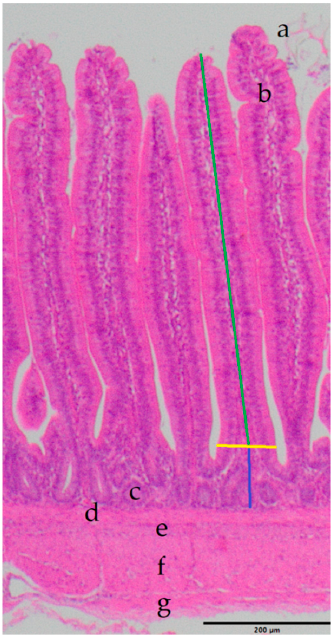
Figure 1. Example image: HE staining from the ileal intestinal wall, measuring lines included. Scale bar = 200 µm. Green: height; yellow: width; blue: crypt depth; a = Villus intestinalis, b = Lamina propria mucosae, c = Lieberkuhn crypt, d = Lamina muscularis mucosae, e = Tela submucosa, f = Tunica muscularis, g = Tunica serosa.